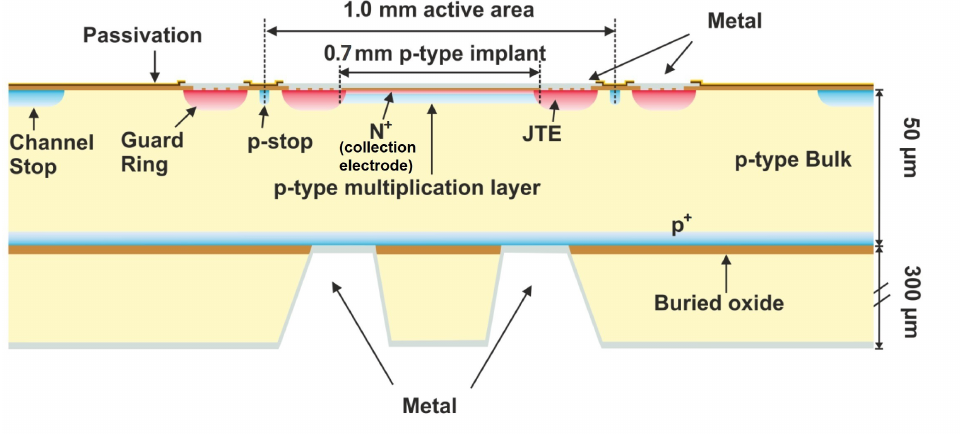
Figure 1. Cross section of a single pad LGAD diode structure.